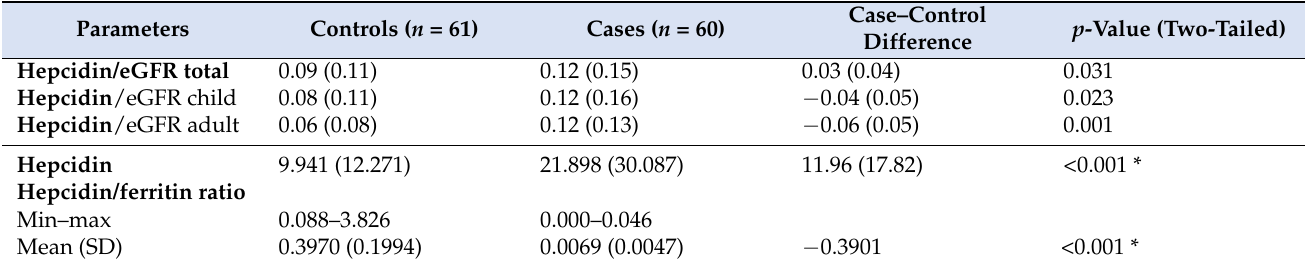
Table 4. Comparison of hepcidin, hepcidin/ferritin and hepcidin/eGFR ratio between controls and cases.